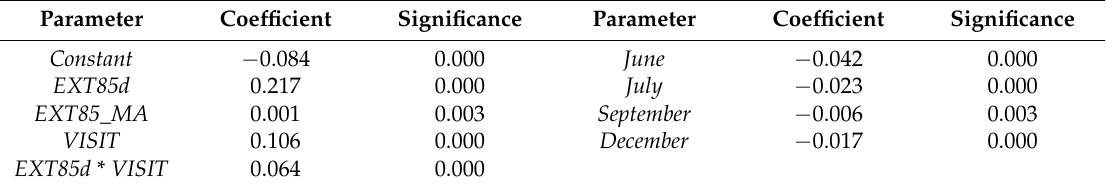
Table 2. Estimated coefficients of the independent variables (first multiple linear regression model).